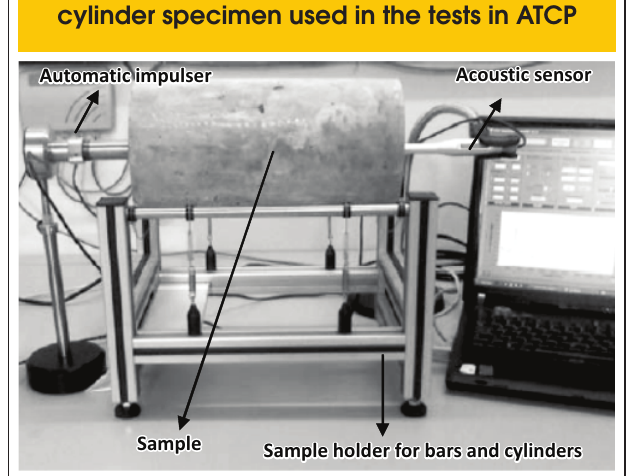
Figure 6 – Apparatus for dynamic testing of cylinder specimen used in the tests in ATCP